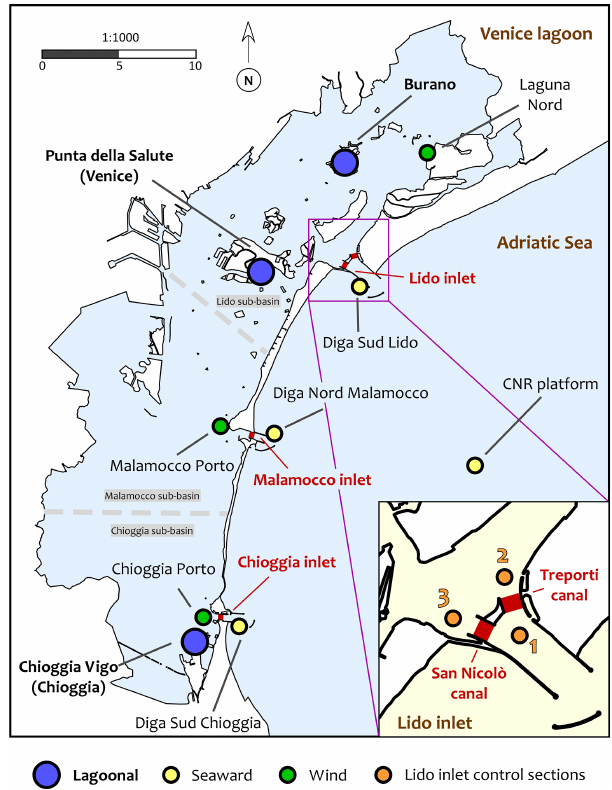
Figure 1. The Venice lagoon with the location of the watersheds (dashed grey lines) and the Mo.S.E. barriers (thick red lines). The bullets show the location of wind (green) and tide stations (blue, lagoonal gauges; yellow, seaward gauges) used in the present work, coming from the database of the Tidal Forecast Centre of the Venice Municipality (Centro Previsioni e Segnalazioni Maree,